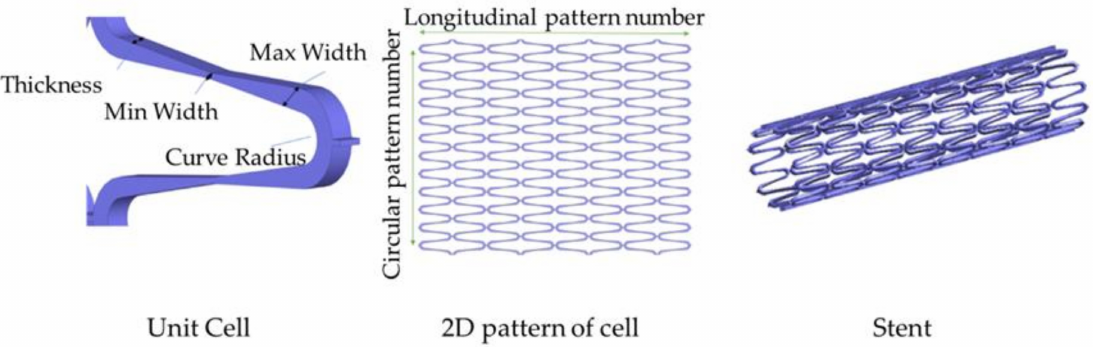
Figure 18. Non-uniform size of stent